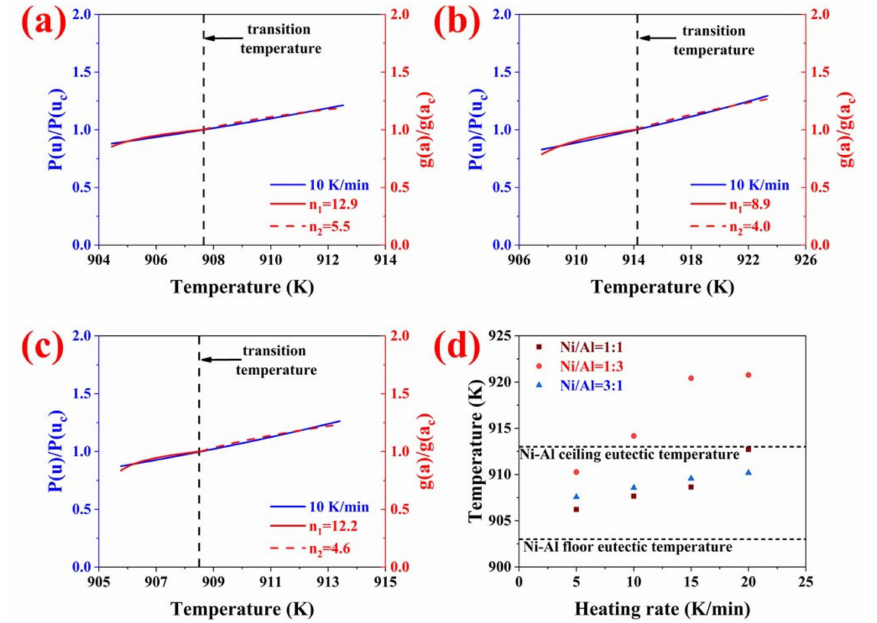
Figure 5. The comparison between the reaction curves and the test reaction curve at 10 K/min ( a ) Ni/Al = 1:1; ( b ) Ni/Al = 1:3; ( c ) Ni/Al = 3:1; ( d ) the transition temperature T α